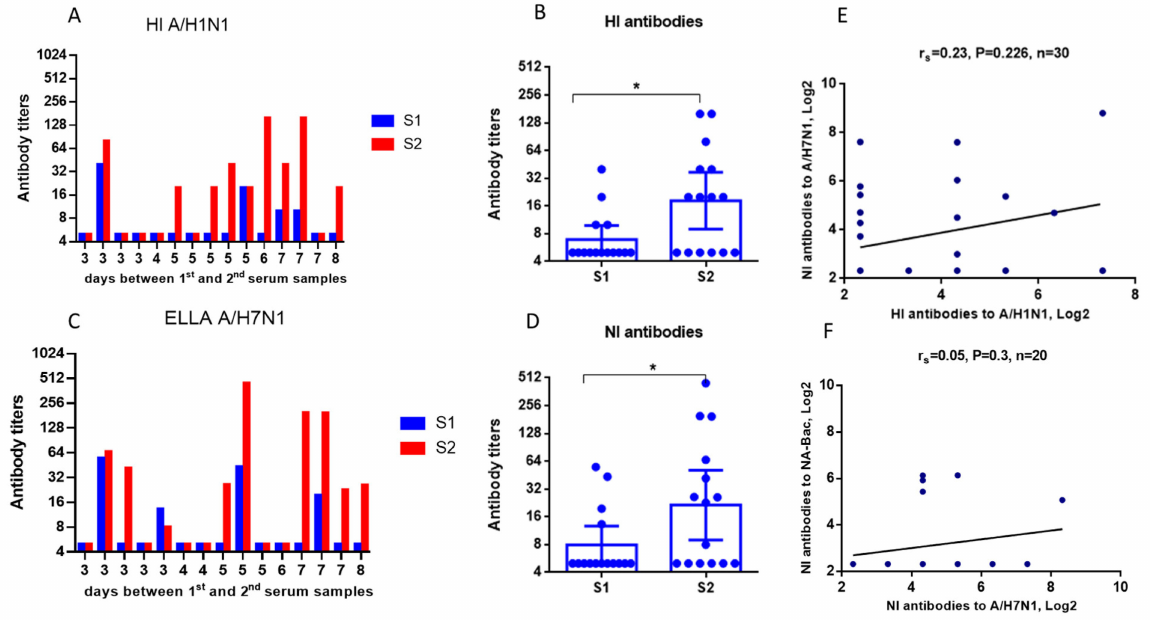
Figure 4. Results of the assessment of HI and NI antibodies in the paired sera of patients with a con- firmed influenza infection (n = 15). S1—sera obtained on admission to the hospital. S2—sera obtained on days 3–8 after hospitalization. ( A ) HI antibody titers to A/California/07/2009 (H1N1)pdm09 influenza virus in individual sera. ( B ) Average HI antibody titers. Each dot represents an individ- ual serum. Data are represented as geometric means with a 95% CI. *— p < 0.05. ( C ) NI antibody titers in individual sera determined by ELLA using the A/H7N1 influenza virus. ( D ) Average NI antibody titers. Each dot represents an individual serum. Data are represented as geometric means with a 95% CI. *— p < 0.05. ( E ) Correlation analysis of HI and NI antibody titers (Spearman’s r). ( F ) Correlation analysis of HI and NI antibody titers (Spearman’s r) among patients with ≥ 4-fold HI antibody